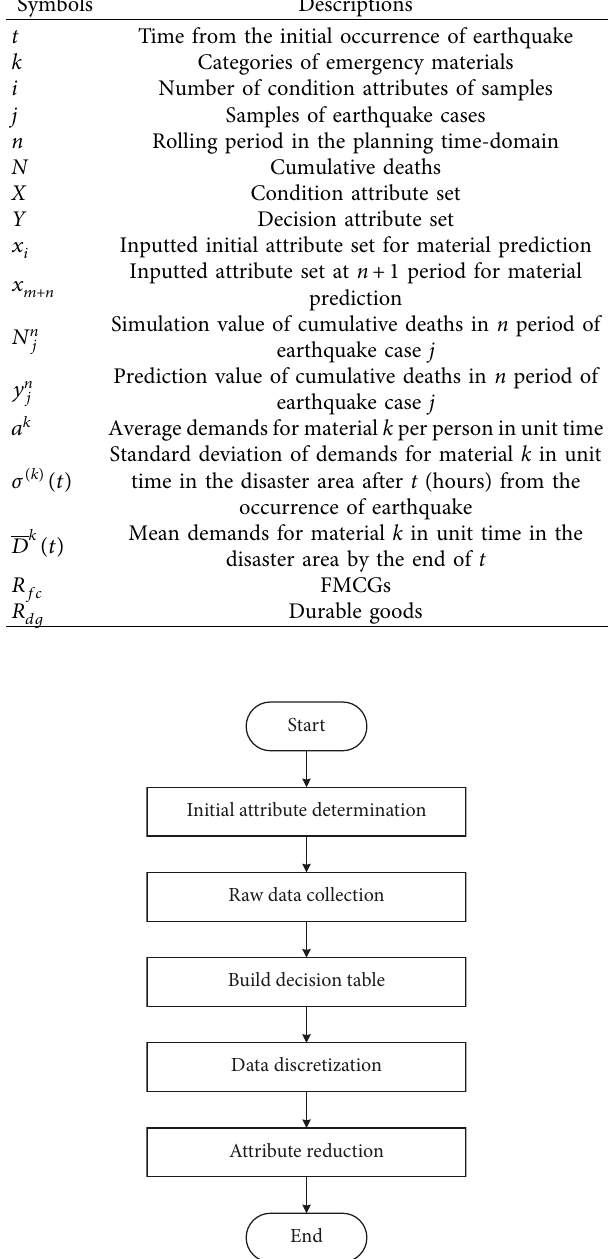
Table 1: Definitions and descriptions of model symbols. Symbols